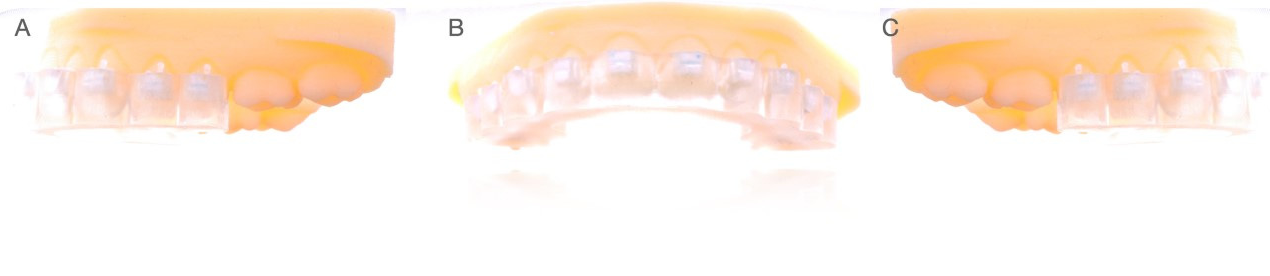
Figure 3. ( A ) Lateral left, ( B ) frontal, and ( C ) lateral right view of the fixed buccal multibracket appliances with the bonding trays on the anatomically based acrylic resin models.